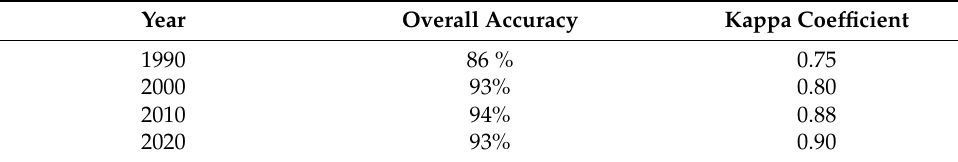
Table 3. Overall accuracy and kappa coefficients by year .